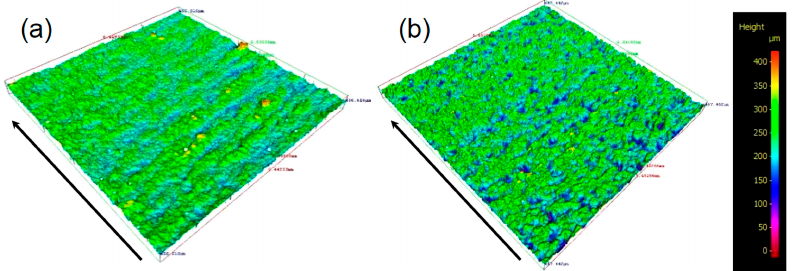
Figure 5. Surface conditions of optimized processing parameters for ( a ) non-mulitspot (N6) and ( b ) mulitspot Ti-6Al-4V sample (M25) observed under Alicona IFM, where the characterized area is 6.5 × 6.5 mm. The arrows indicated the build direction.